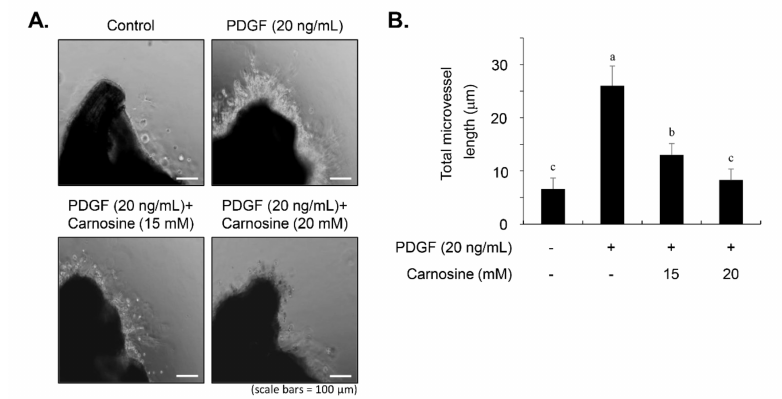
Figure 10. Carnosine attenuated the PDGF-stimulated sprout outgrowth formation of VSMCs from aortic rings. Sprout outgrowth of VSMCs was evaluated using aortic ring assay ex vivo. Aortic rings derived from rats were placed and embedded in Matrigel in 24-well plates. Aortic rings were incubated with the indicated concentrations of carnosine for 45 min and then stimulated with PDGF (20 ng / mL) for 5 days. ( A ) The sprout outgrowth responses were observed on light microscopic images. ( B ) Quantitative analysis of the aortic ring assay was performed by measuring sprout length. Bar graph shows the fold change in expression compared with the control. The values are expressed as the mean ± SD values of three independent experiments. The di ff erent letters indicate significant di ff erences between the groups ( p <